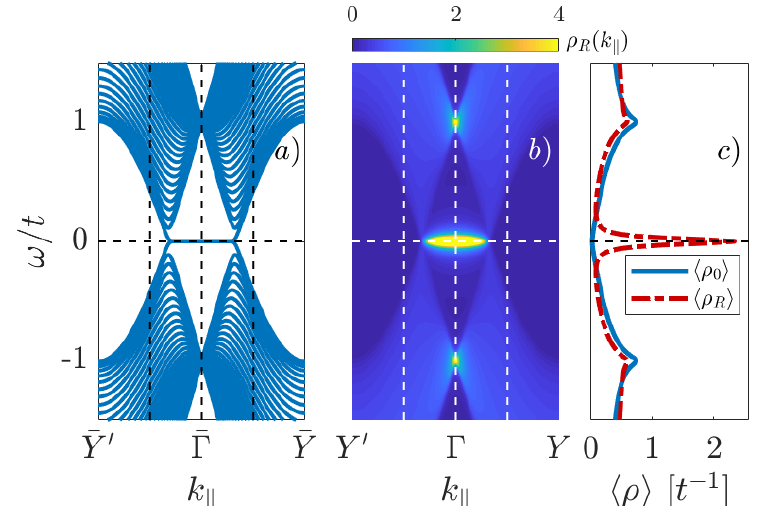
= 40 sites. The sites